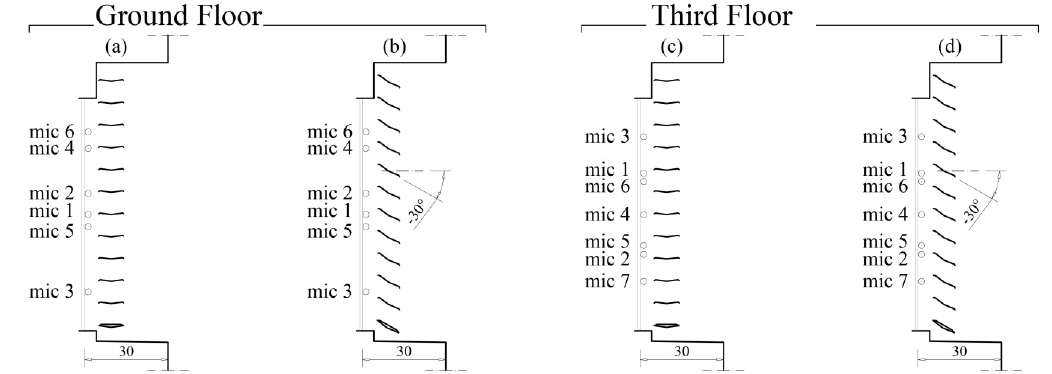
Figure 6. Scheme of the mutual microphone positions and the tilt angle of the louvers. ( a , b ) represent the ground floor configuration with un-tilted louvers and with a tilt angle of − 30°, respectively; ( c , d ) represent the third floor configuration with un-tilted louvers and with a tilt angle of − 30°, respectively.